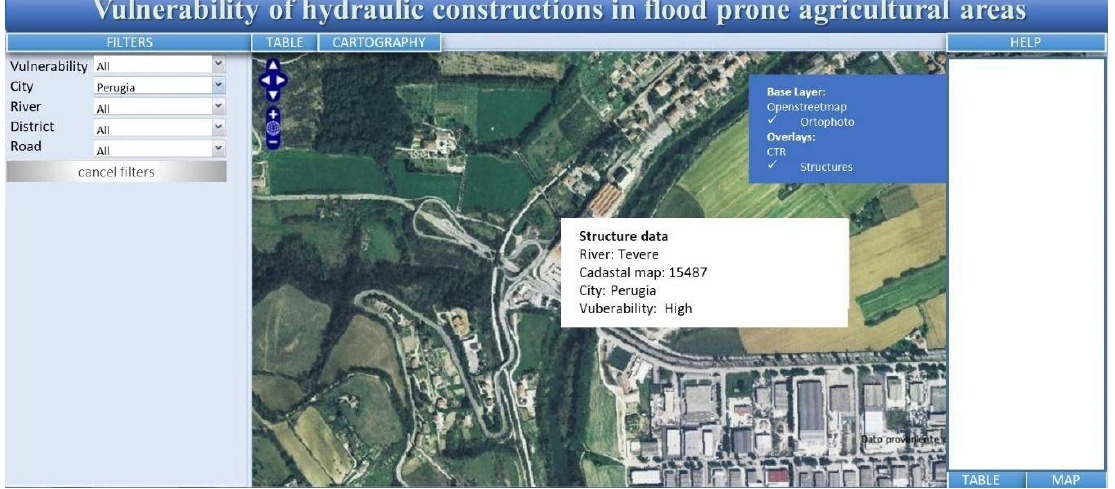
Figure 12. Map detail of the urban context in which the structure is located.